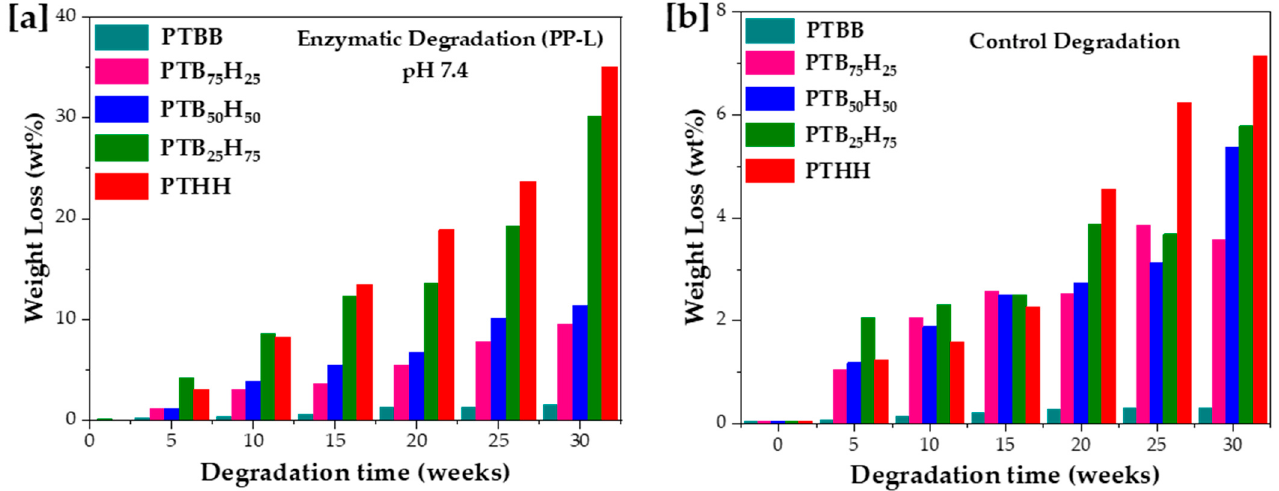
Figure 8. [ a ] Enzymatic degradation and [ b ] passive hydrolysis for the poly(1,4-bis(2- hydroxyethyl)benzene thiophenedicarboxylate) (PTBB), poly(hexylene thiophenedicarboxylate) (PTHH), and poly(hexylene 2,5-thiophenedicarboxylate-co-bis(2-hydroxyethoxybenzene)